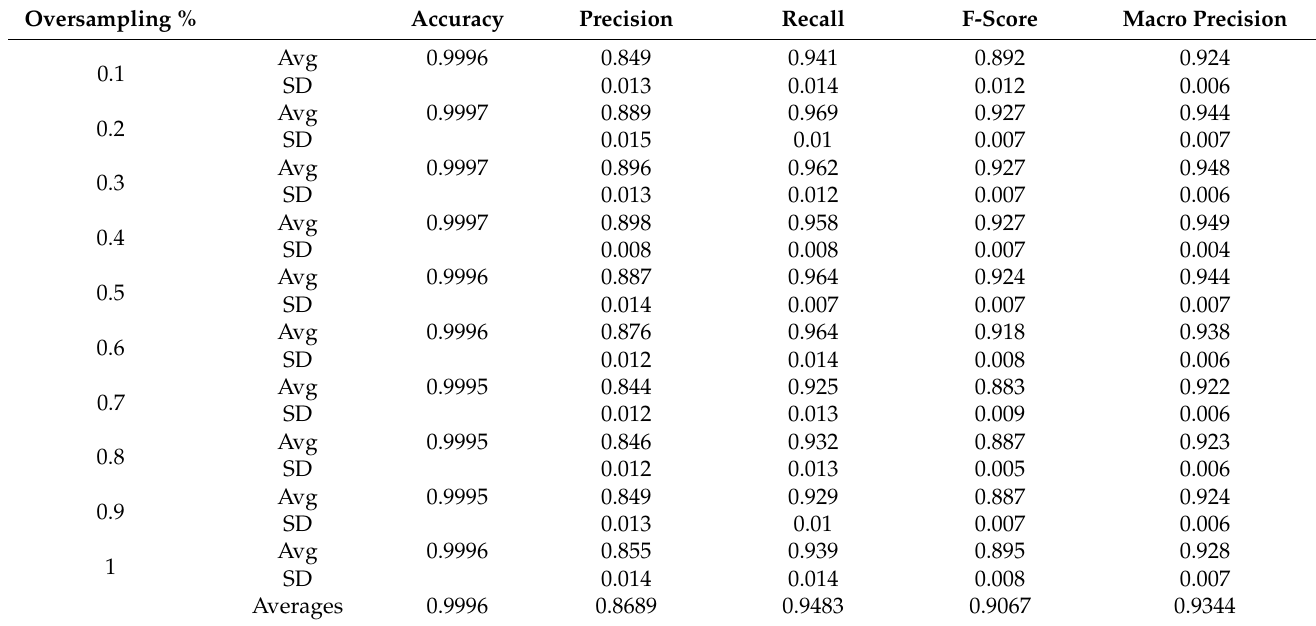
Table 7. UNSW-NB15: Shellcode—classification results for random undersampling before splitting.